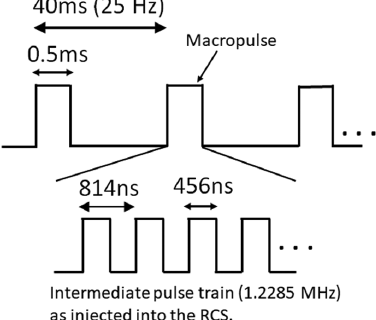
FIG. 8. Schematic view of the H − intermediate pulse structure in each 0.5 ms injection macropulse as injected into the RCS. The intermediate pulses have a frequency of 1.2285